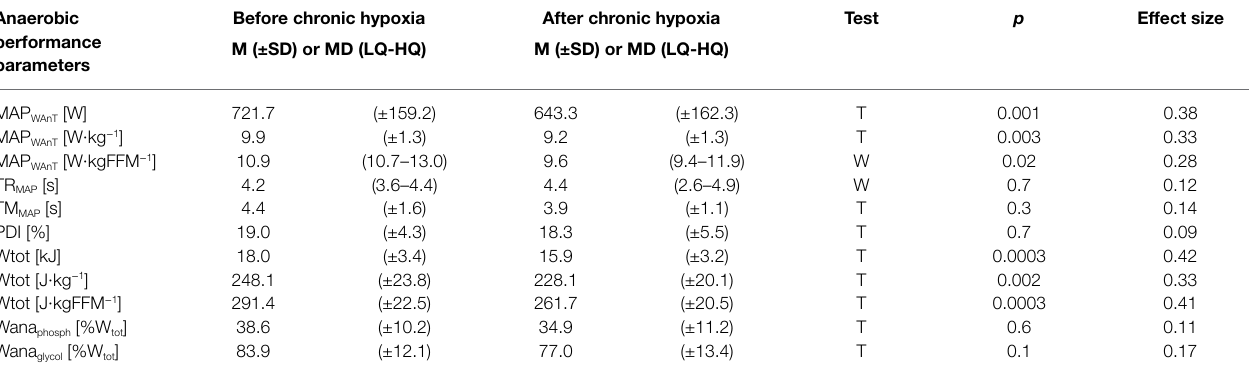
TABLE 2 | Anaerobic performance parameters measured before and after 1 month at very high altitude (mean altitude of 4,900 ± 60 m). Anaerobic performance parameters